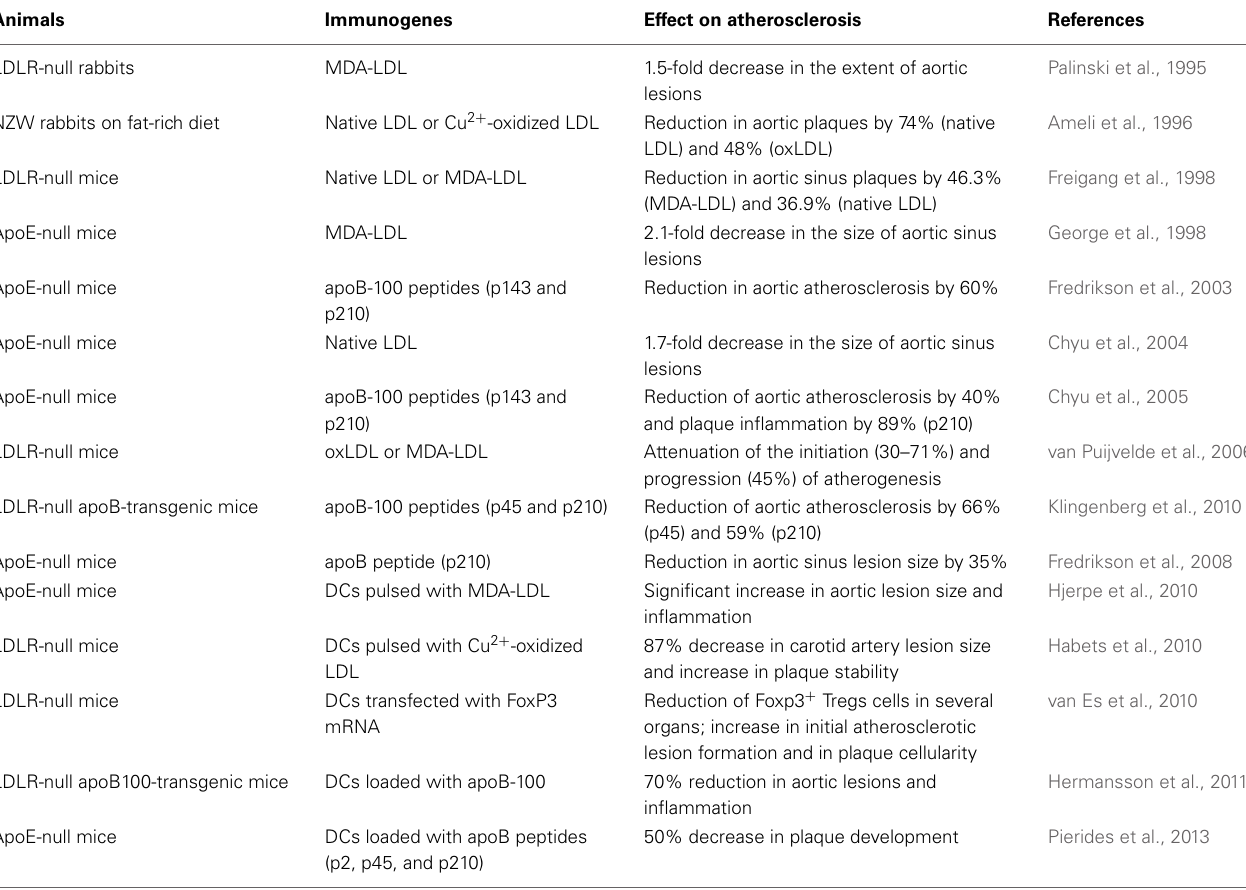
Table 1 | Examples of anti-atherosclerosis immunization of experimental atherosclerosis animal models involving LDL or its related peptides.